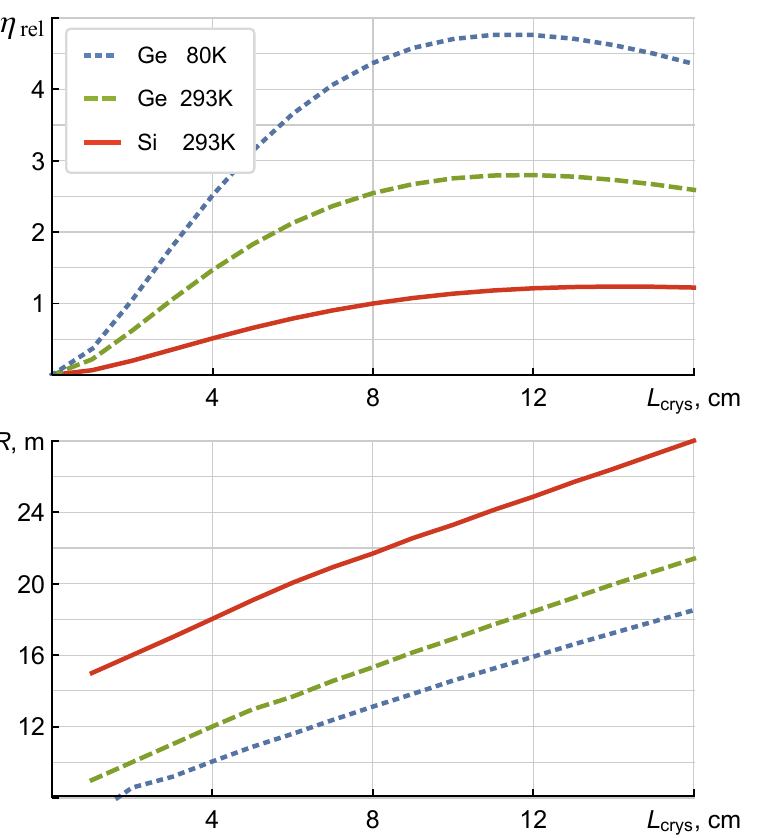
Figure 6 . Relative e(cid:14)ciency of MDM precession measurement (cid:17) rel with respect to the e(cid:14)ciency of default crystal as a function of crystal length L crys (upper plot). Optimal curvature radius R as a function of crystal length L crys (bottom plot).